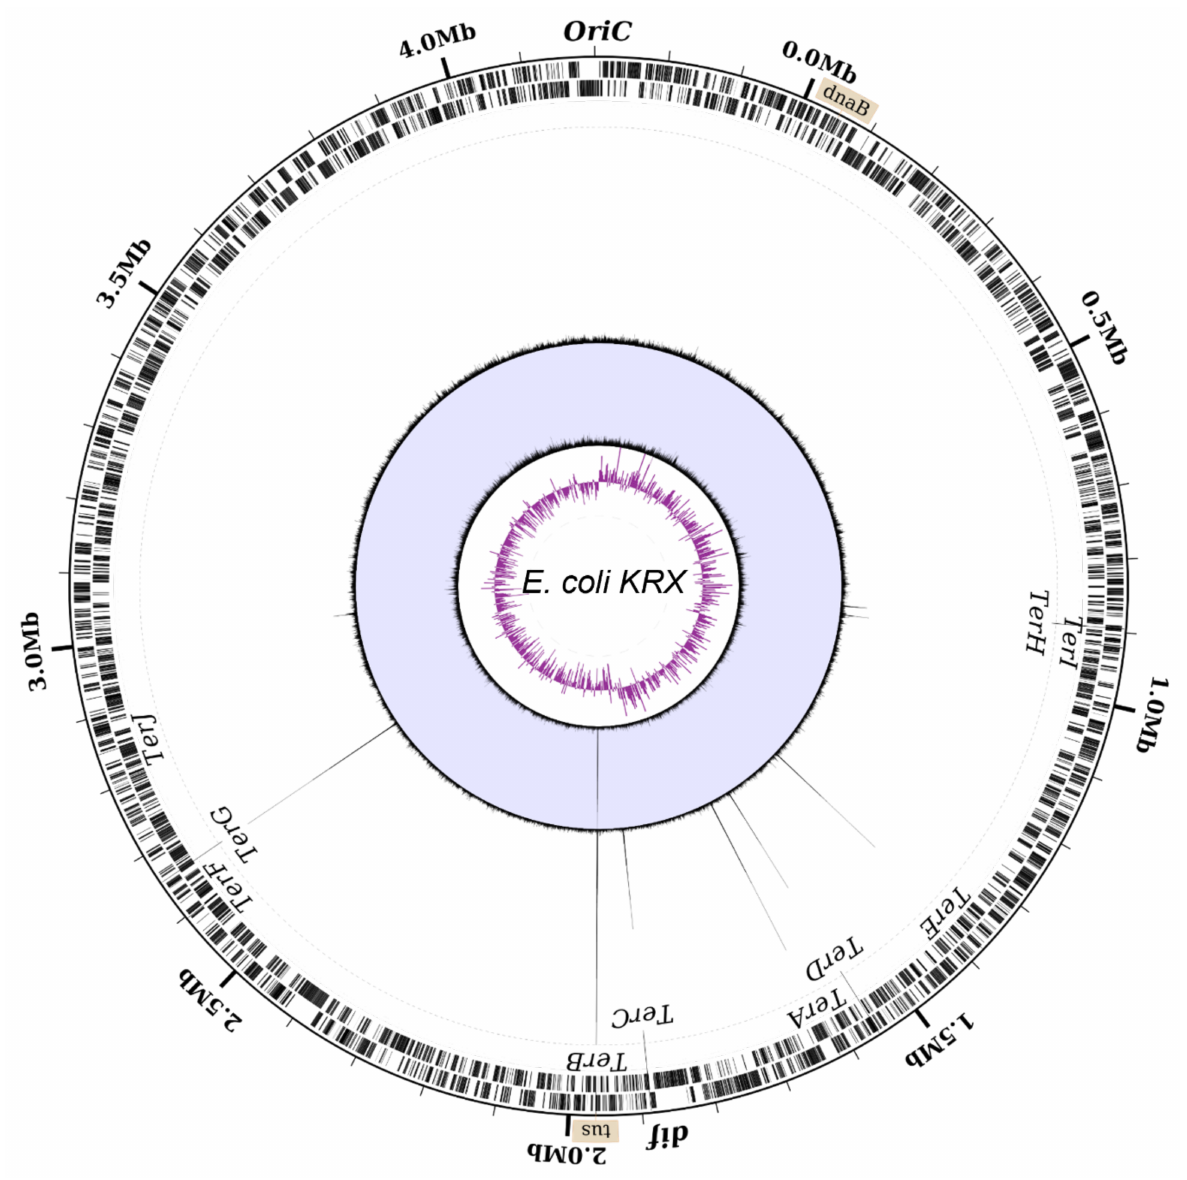
Figure 2. Circular representation of E. coli KRX chromosome with mapped ChIP-Seq coverage. From the outside to the centre of the circle: labelled forward and reverse genes; genomic location of sites and genes involved in DNA replication termination; combined ChIP-Seq read coverage (max = 430 reads at TerB ), Input DNA read coverage (max = 230 reads at the tus gene), GC-skew over a 5000 bp moving window. The GC-skew switches polarity at the replication origin and